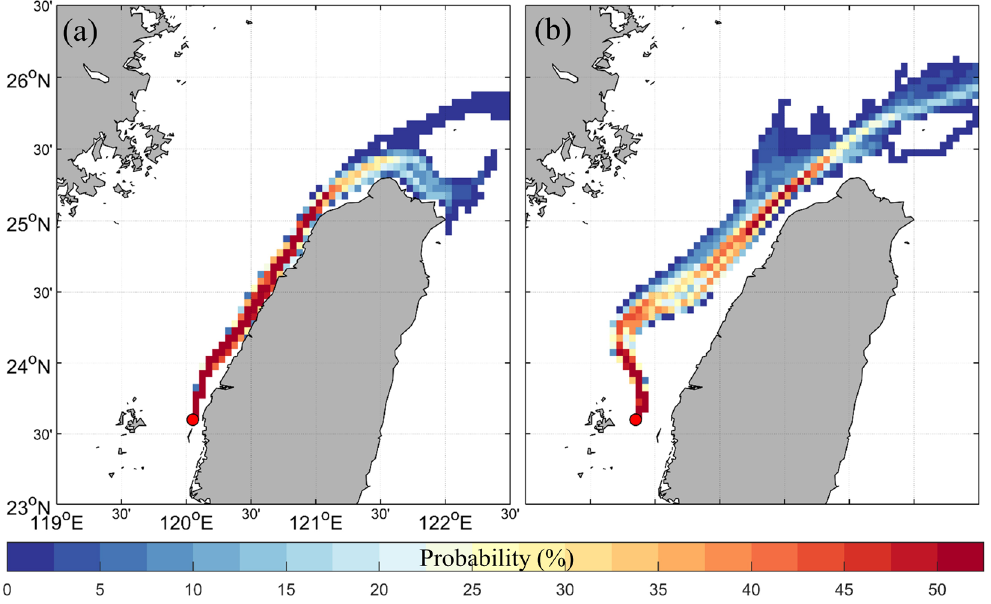
Figure 10. Probability density distributions of simulated trajectories of floats deployed from ( a ) nearshore and ( b ) offshore points without tidal forcing.